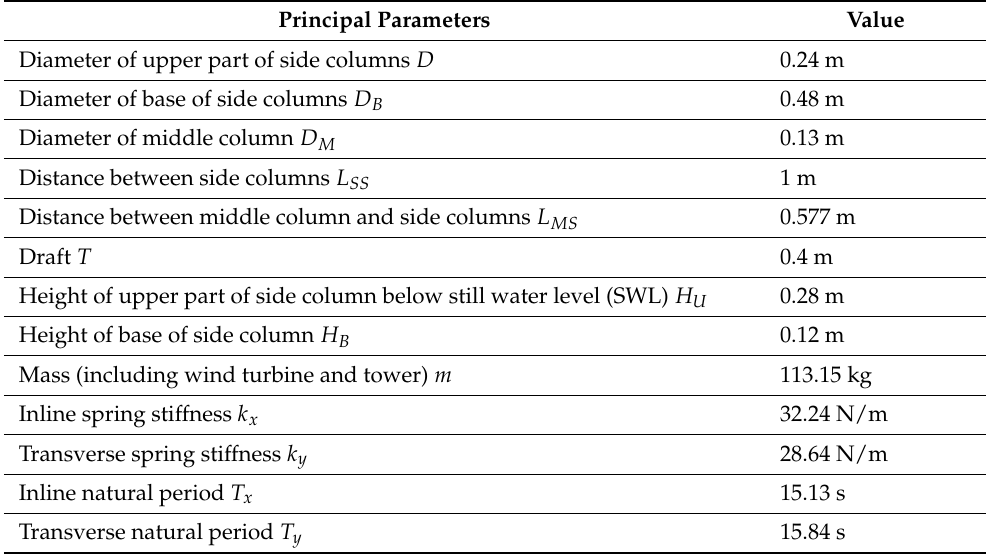
Table 1. Principal parameters of FOWT